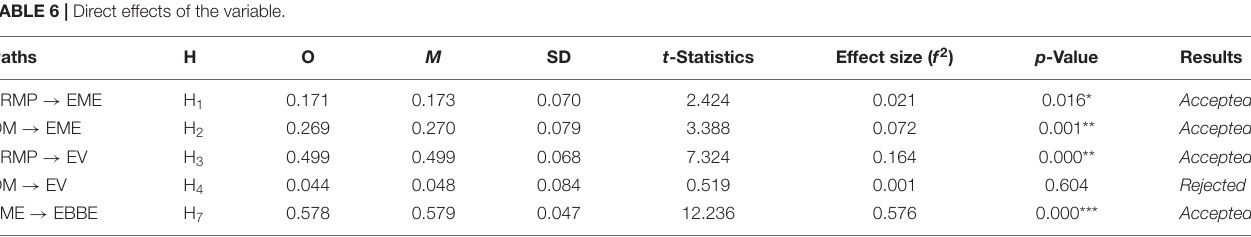
FIGURE 3 | Structural model bootstrapping. SRMP, socially responsible management; OM, organizational morality; EV, employee vitality; EME, employees’ morale engagement; EBBE, employee-based brand equity. TABLE 6 | Direct effects of the variable.